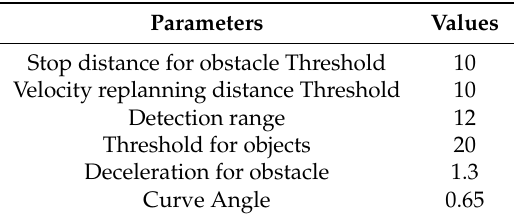
Table 4. Experimental Parameters for Planning Layer.